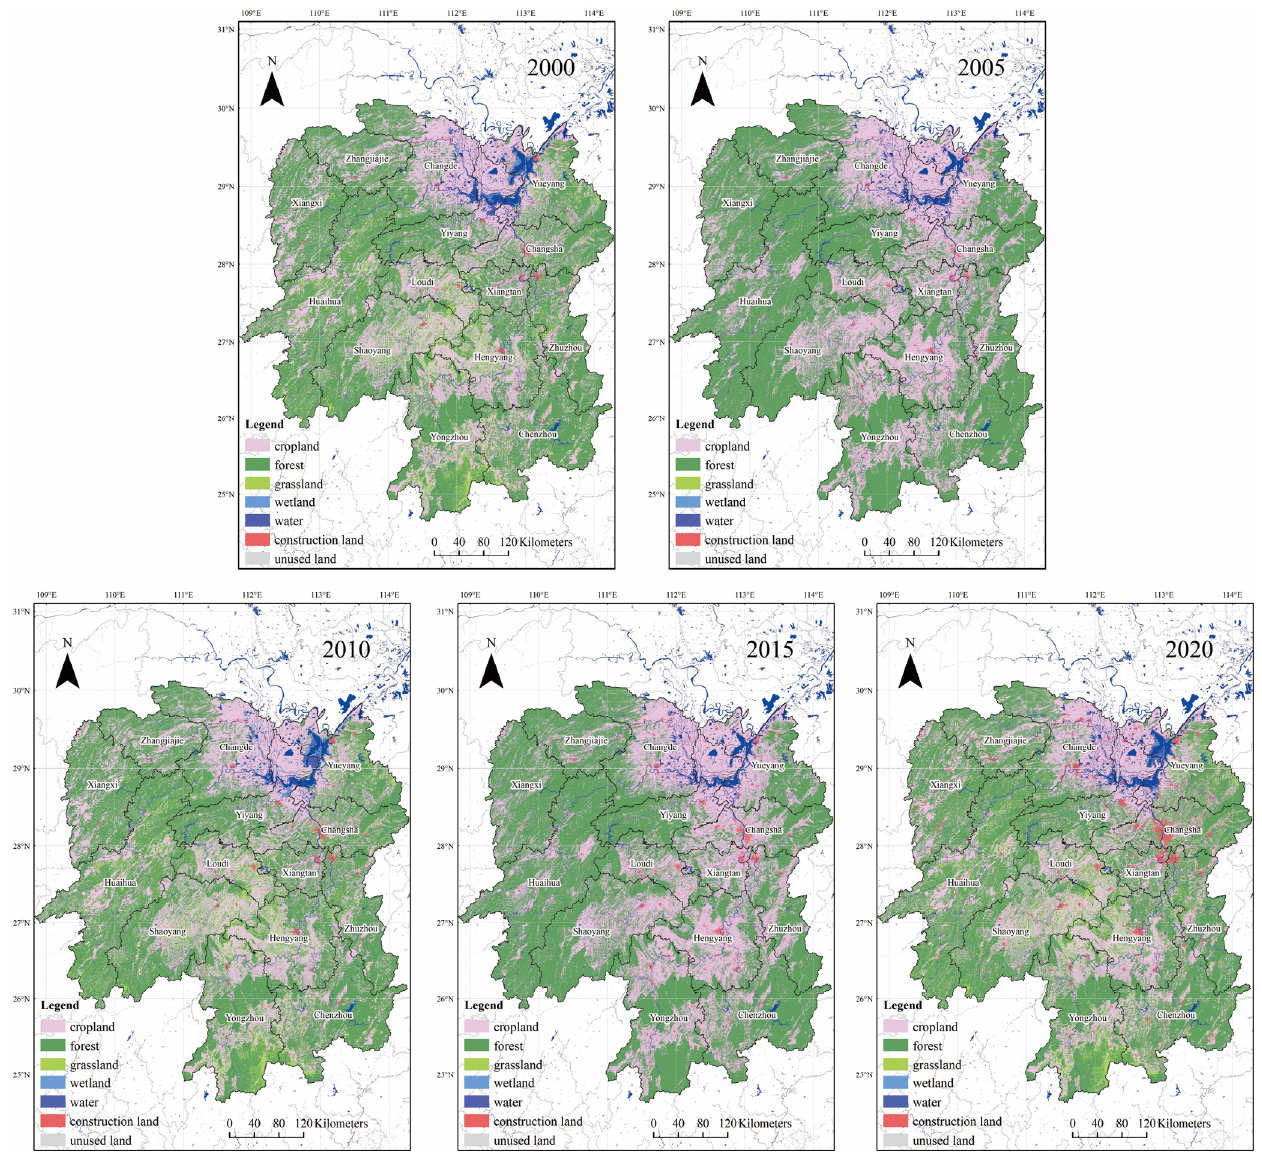
Figure 1. Administrative division and land use classification map of each city and prefecture in Hunan Province.